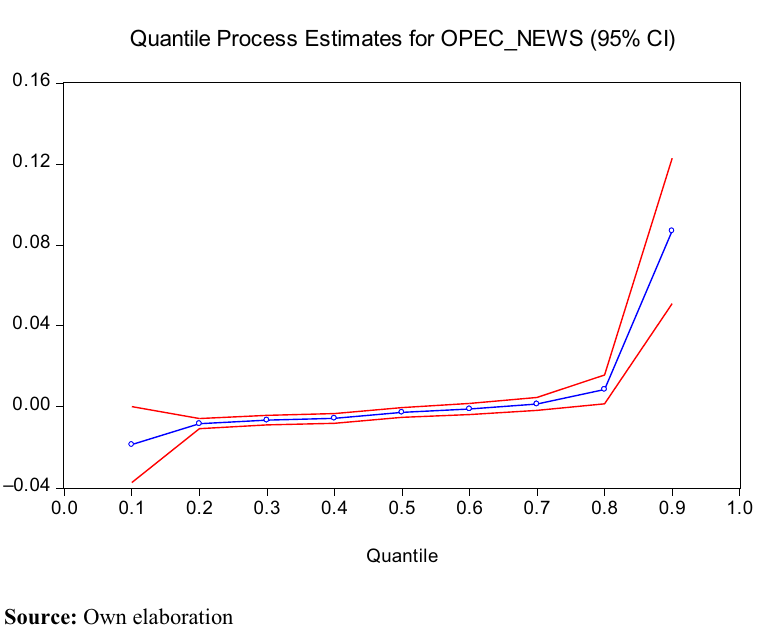
Figure 15. The quantile process estimates for OPEC news on the gasoline RBOB futures over the period from April